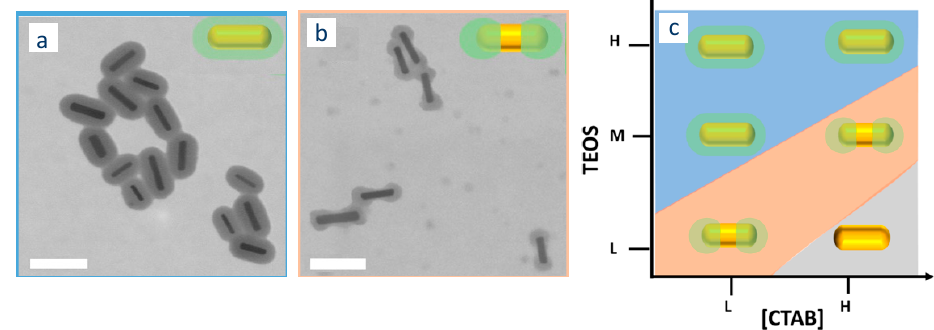
Figure 11. TEM images of AuNR@SiO 2 obtained at constant TEOS concentration and with ( a ) 1 mM CTAB and ( b ) 9 mM CTAB. ( c ) Shape of the silica coating under various conditions according to Wang et al. [85].